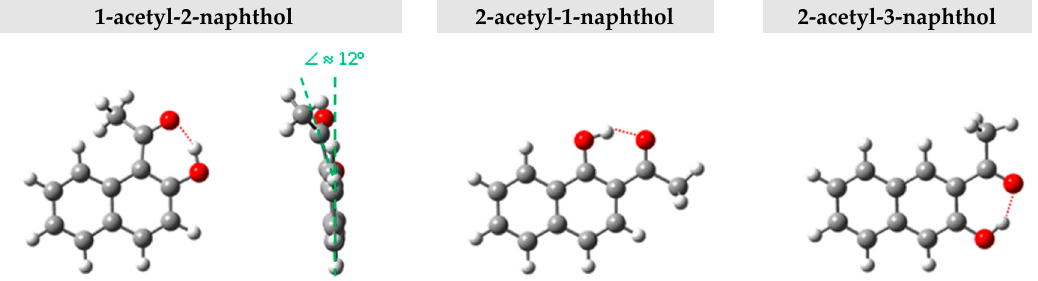
Figure 3. Optimized geometries corresponding to the global minima of the o -acetylnaphthol isomers